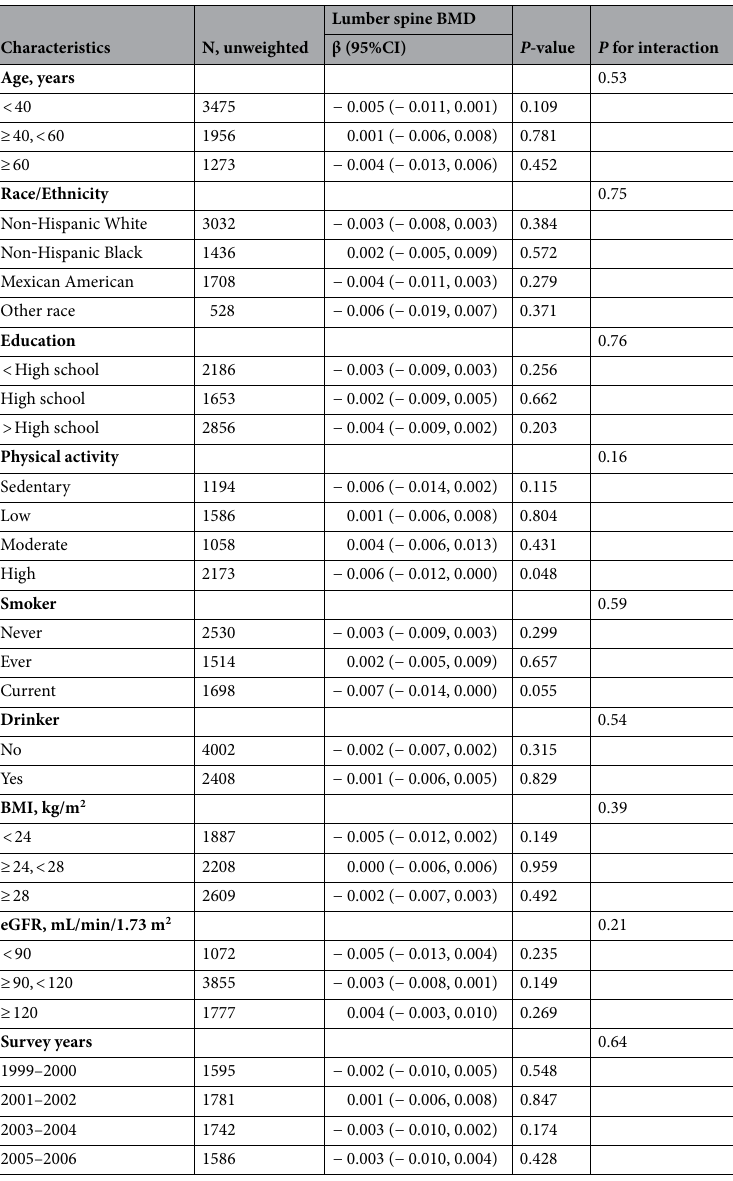
Table 4. Subgroup analyses of the association of serum uric acid with lumbar bone mineral density, weighted. The model was adjusted for age, race/ethnicity, education, physical activity, smoking, drinking, body mass index, calcium supplementation, energy intake, protein intake, serum calcium, serum phosphorus, 25-OH-D, parathyroid hormone (PTH) serum alkaline phosphatase (ALP), C-reactive protein (CRP), serum albumin and estimated glomerular filtration rate except the corresponding stratification variable. Serum ALP, PTH and CRP were log2 transformed prior to regression